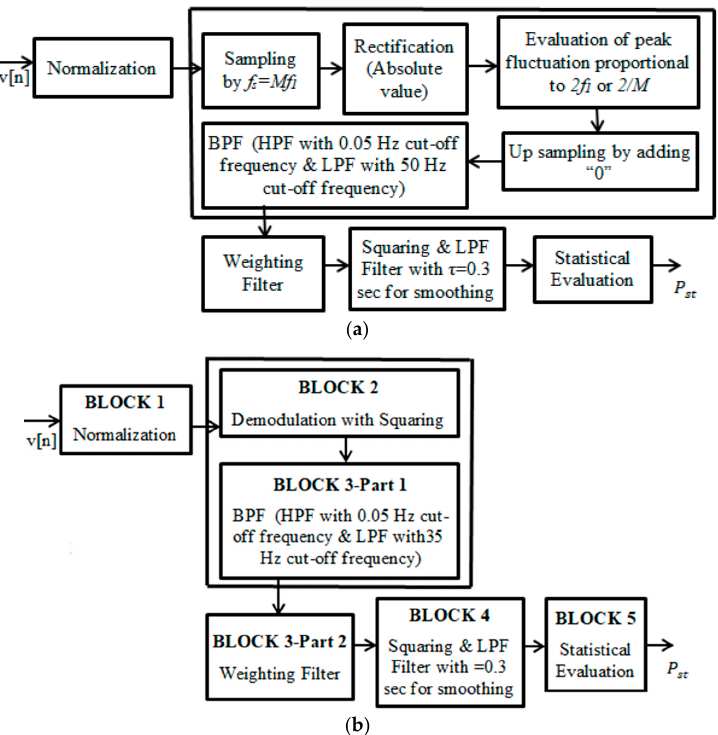
Figure 1. Block diagram of the flickermeters ( a ) Voltage Peak Detection (VPD) flickermeter